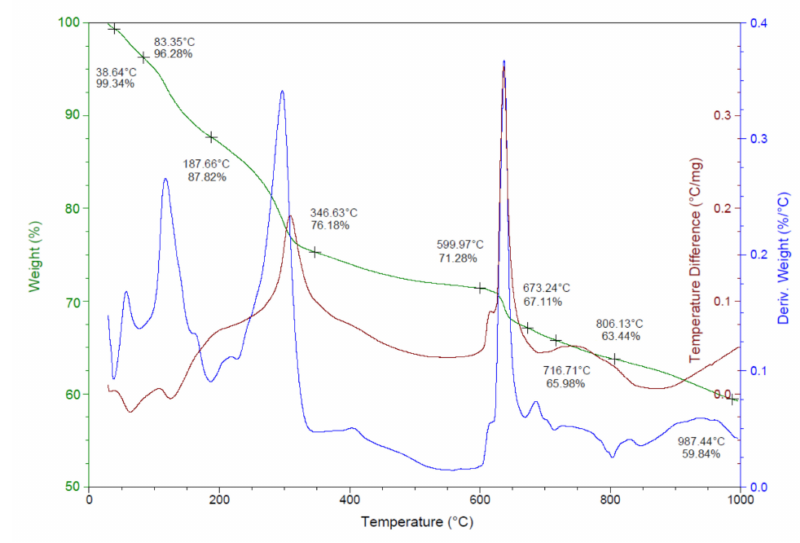
Figure 6. TGA / DSC / DTG graphs of silver